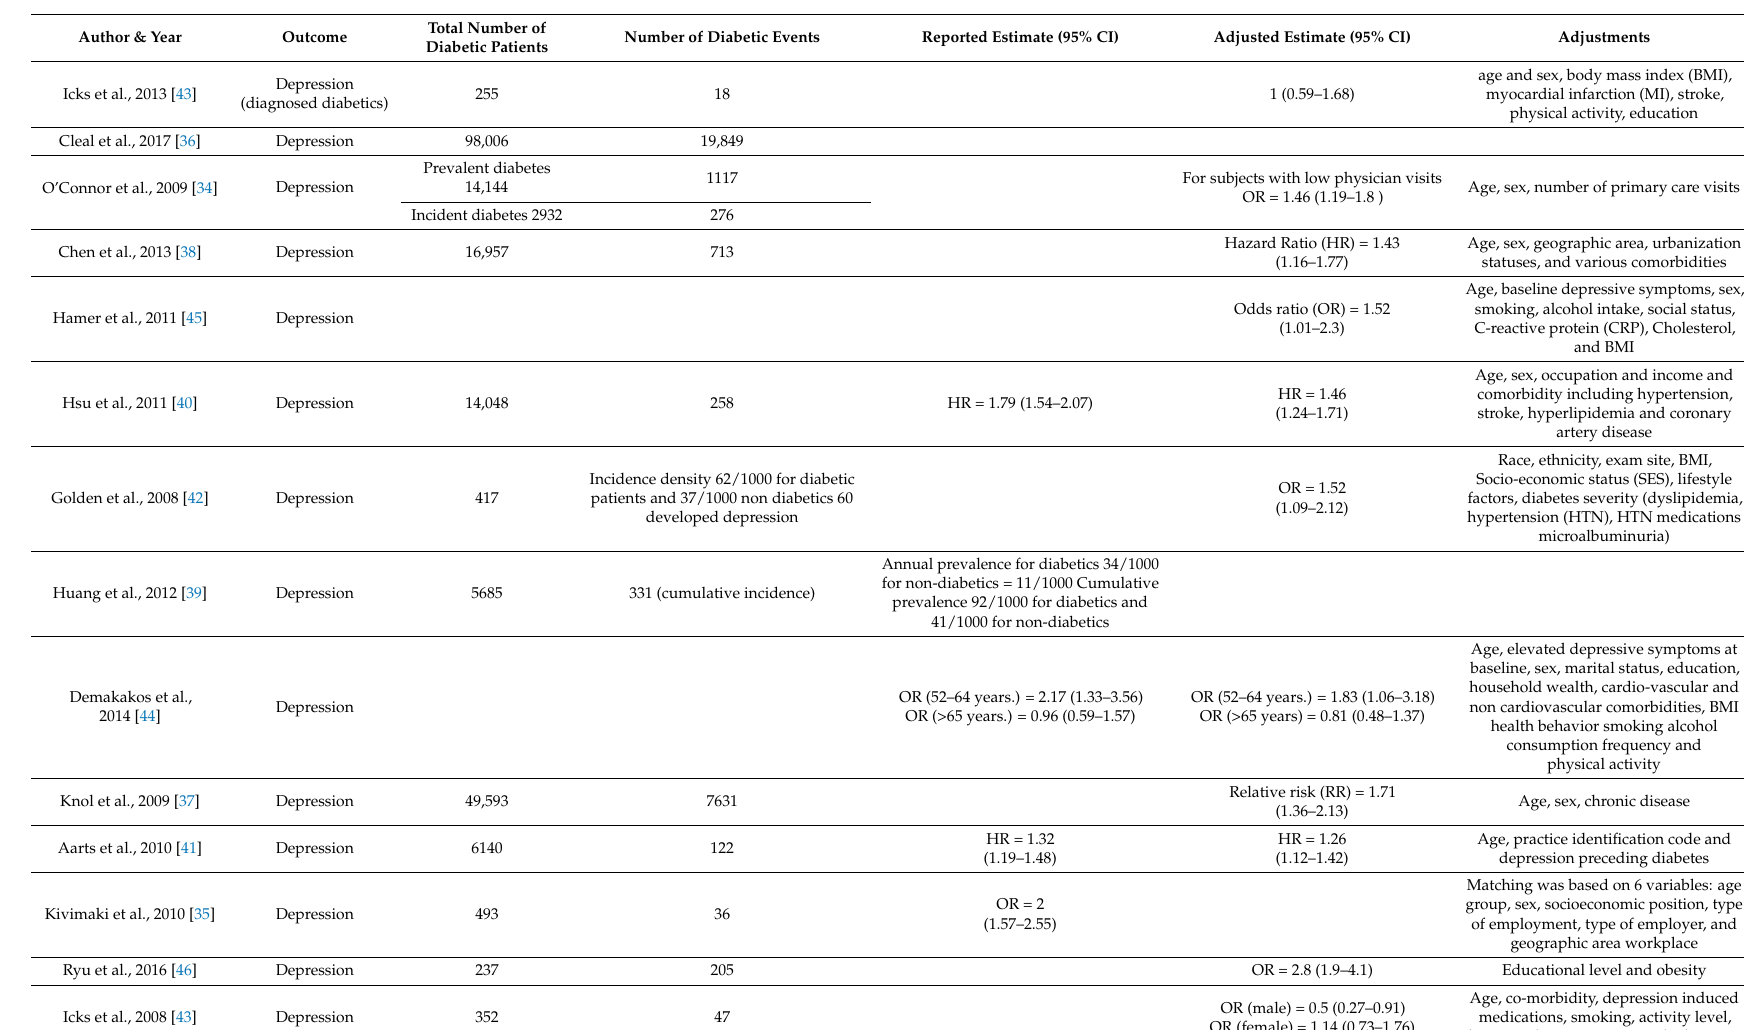
Table 2. Data from selected studies for systematic review and meta-analysis (depression